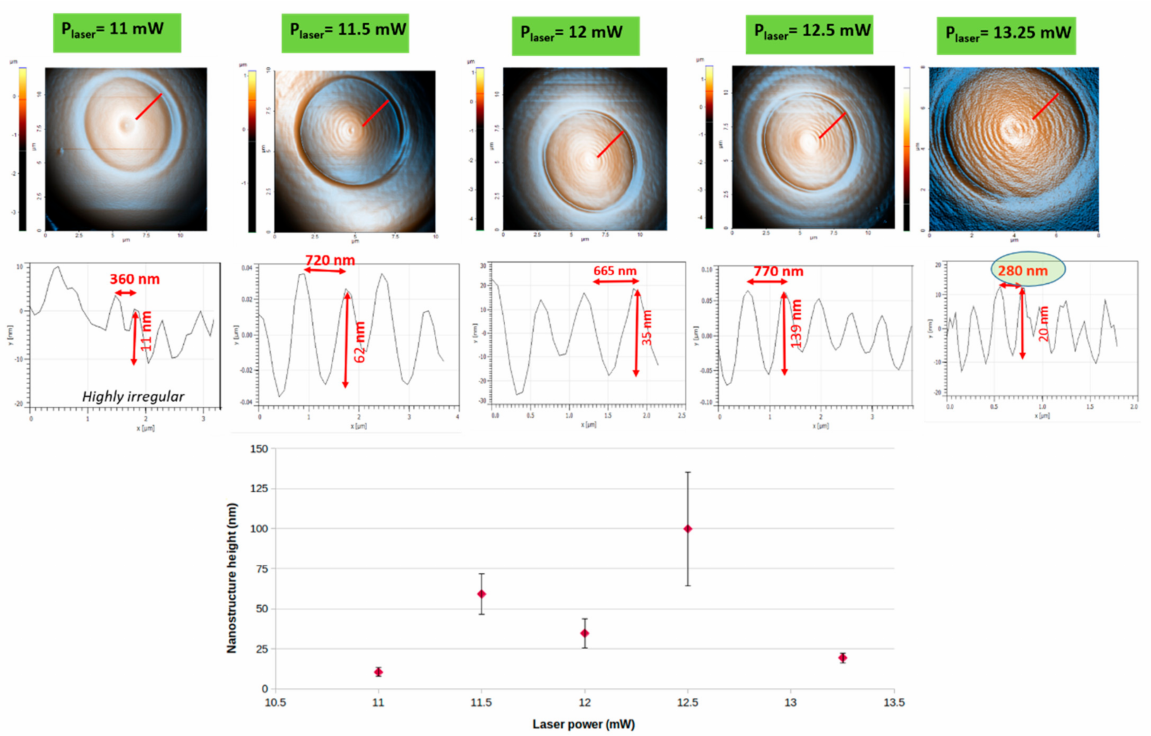
Figure 4. ( Upper panel ) Atomic force microscopy images (AFM) (enhanced colors) of dual-scale structures in the shape of nanostructured mushroom-like pillars (NMPs) fabricated by LDW via TPP of IP-Dip photopolymer, having the same design and fabricated using different laser powers; ( Middle panel ) 2D profiles along the radial segments marked in red in the upper panel. For all samples, the scanning speed was 100 µ m/s; ( Lower panel ) Nanostructures’ heights as a function of incident laser power step (the error bars are the statistical deviations). The greeen oval from the right part of the middle panel points out the best result in terms of laser power